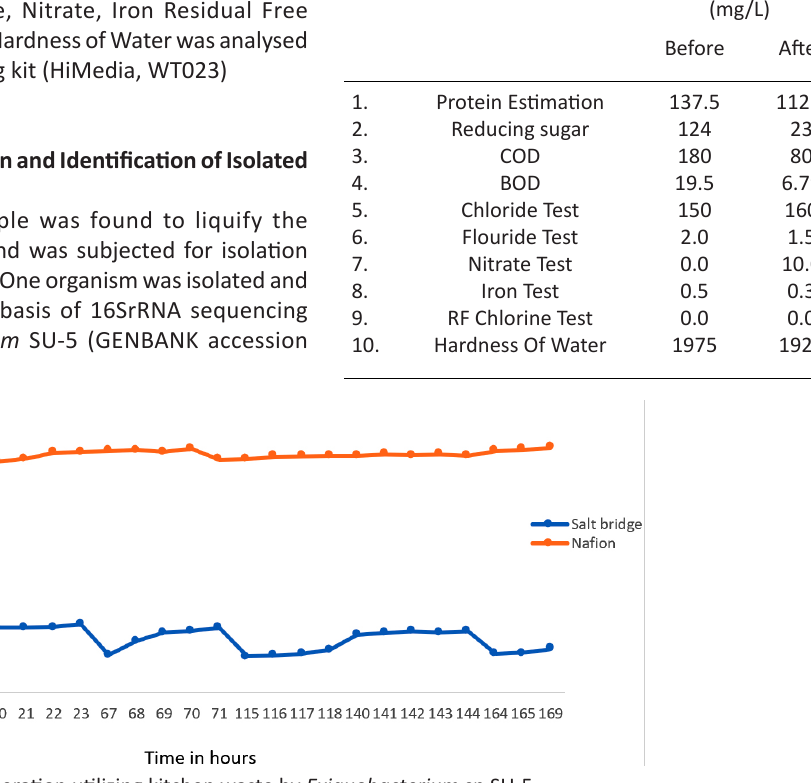
Fig. 5. Electricity generation utilizing kitchen waste by Exiguobacterium sp